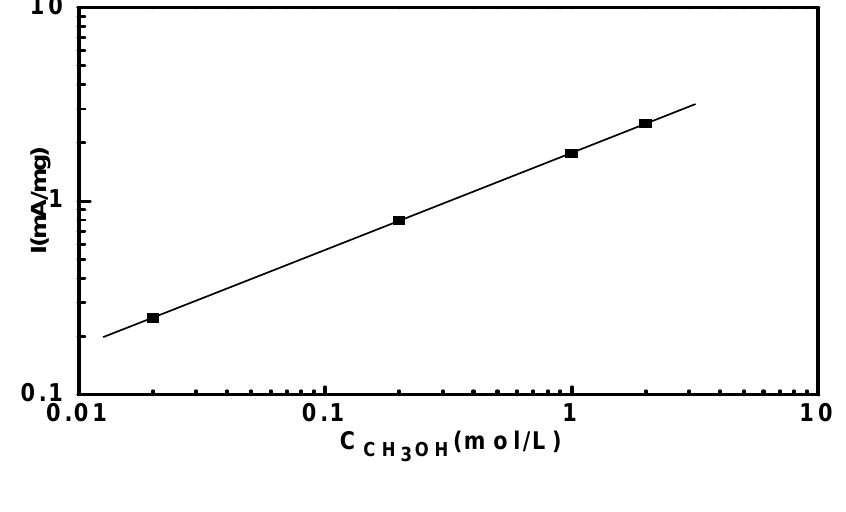
Figure 6. Reaction rate (current density) of methanol electro-oxidation on Pt a function of methanol concentrations in 1.0 M H 0.5